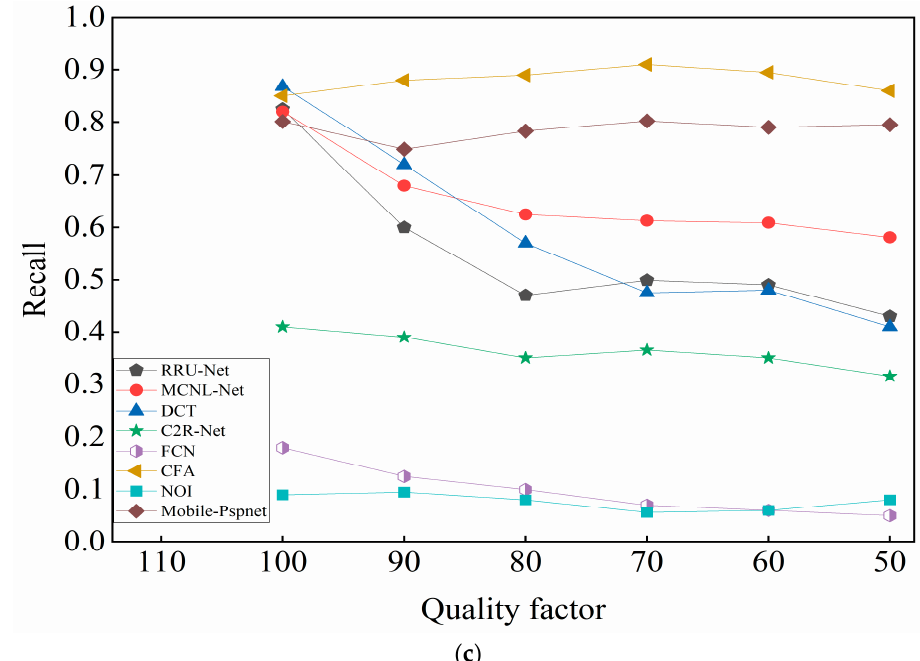
Figure 5. Detection results based on different quality factor compression of CASIA. ( a ) The influence of different image compression quality factors on F-measure; ( b ) The influence of different image compression quality factors on Precision; ( c ) The influence of different image compression quality factors on Recall.